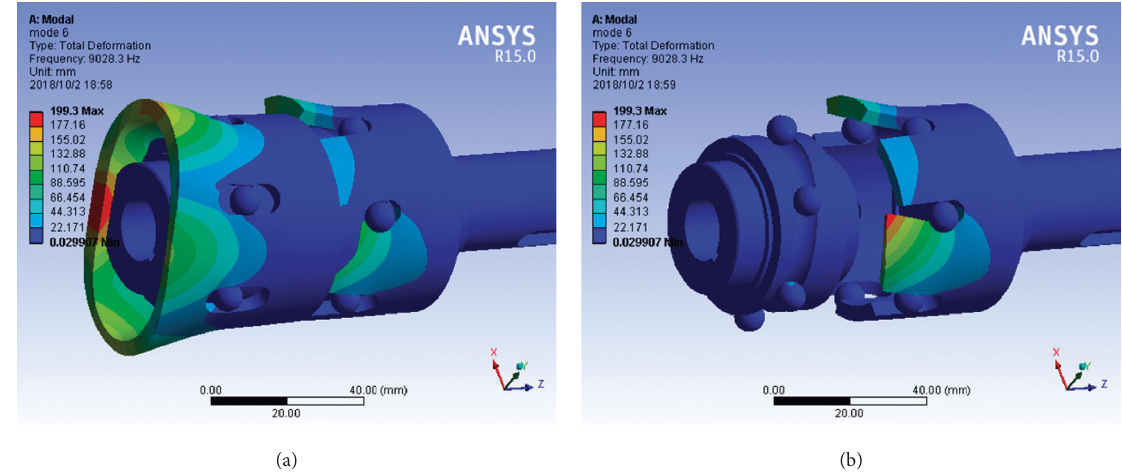
Figure 5: Double-element vibration mode (mode